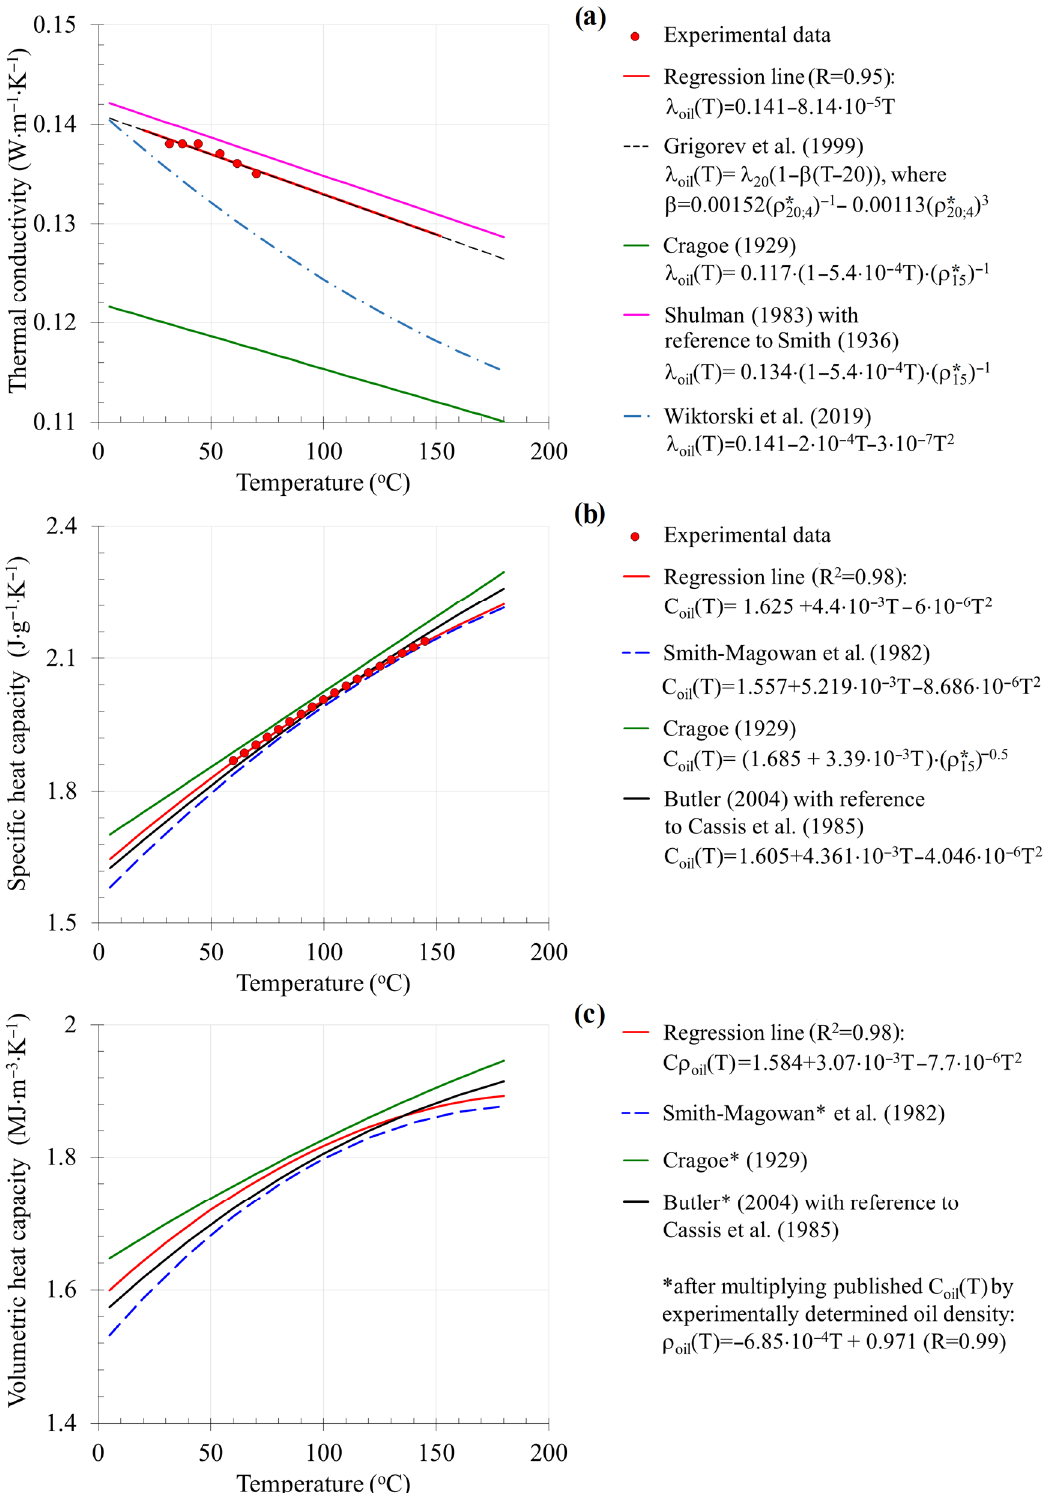
Figure 6. ( a ) Thermal conductivity, ( b ) specific and ( c ) volumetric heat capacity of heavy oil samples from the Karabikulovskoye field in the temperature range from 8 to 180 °C with comparison to published results (see comments in text). The discrepancy between the results of the experiment in the Karabikulovskoye field oil samples and those of Smith [40] and Shulman [41] is less than 2%. Cragoe’s results [42], derived from experimental data with 18 different types of oil and often used in practice (see, e.g., [5]), demonstrate a similar decrease in thermal conductivity with temperature